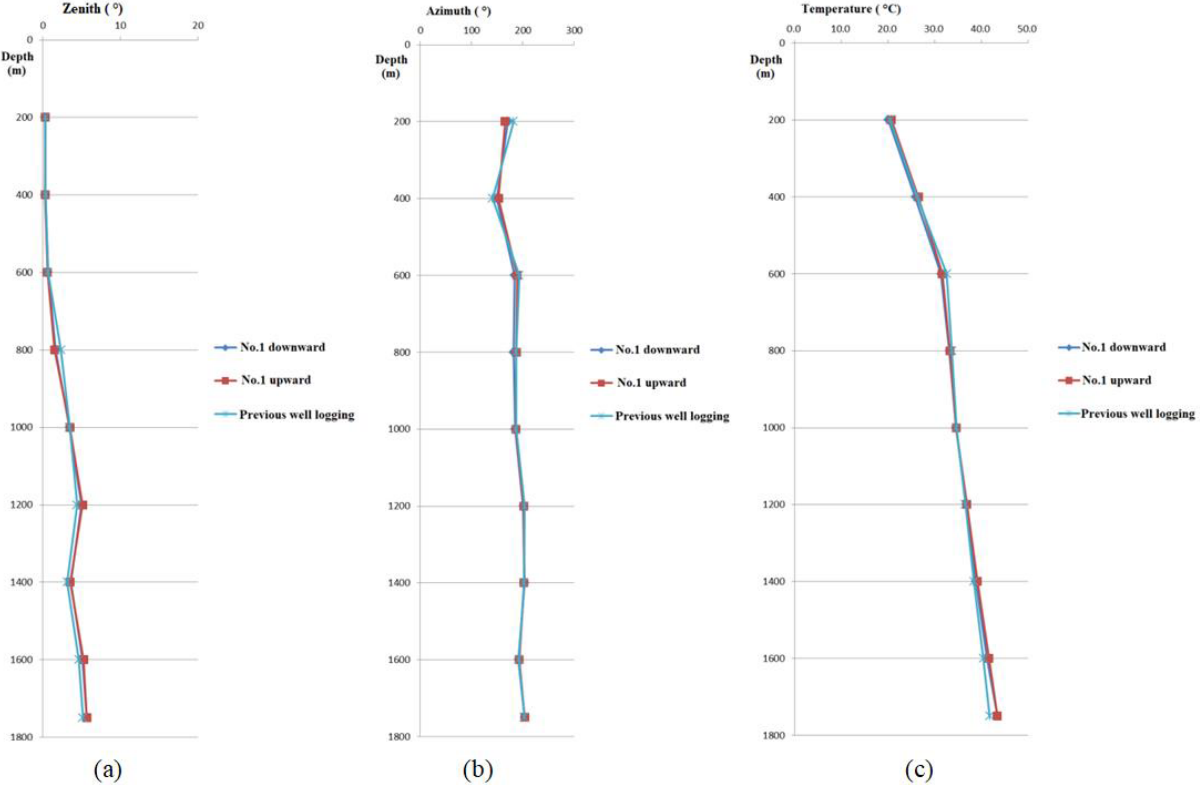
Figure 24. (a) Curve of measured zenith against borehole depth; (b) curve of measured azimuth against borehole depth; (c) curve of measured temperature against borehole